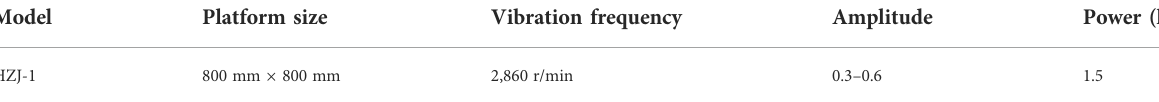
TABLE 14 Main properties of the concrete vibration table.